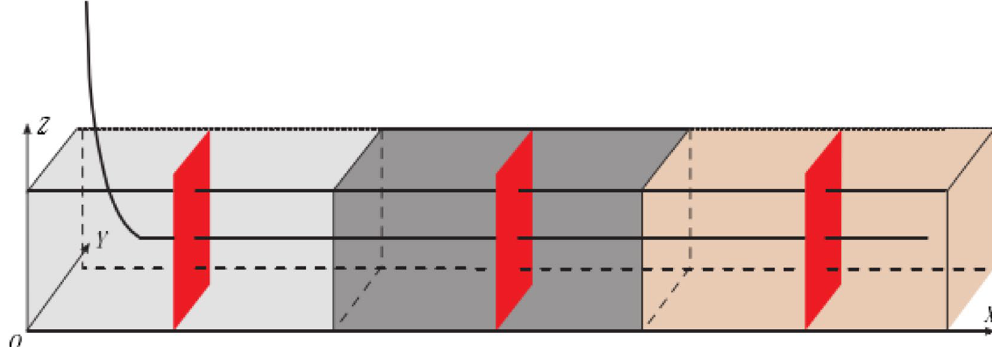
Fig. 1 The schematic of multi-stage fracturing